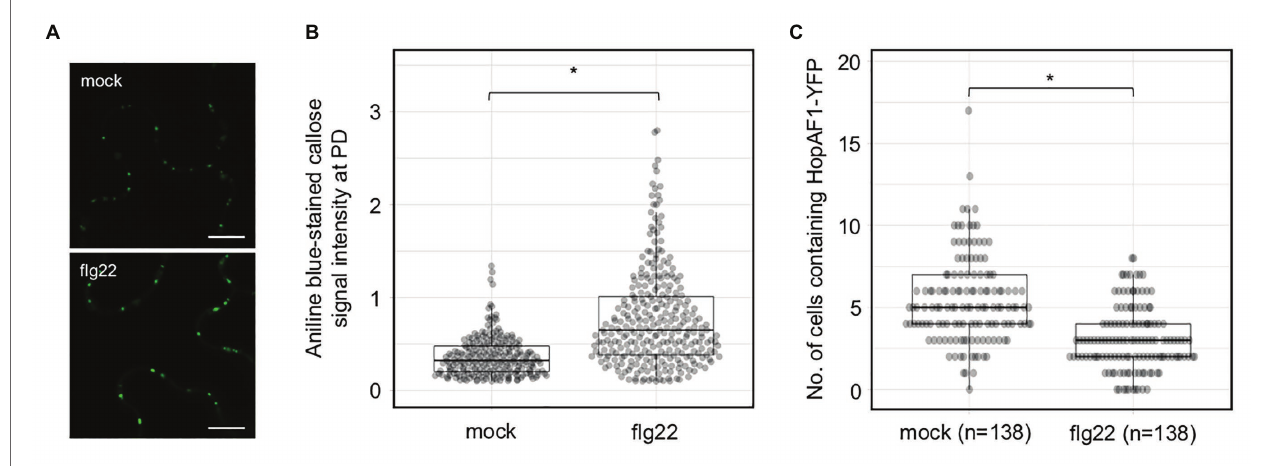
FIGURE 4 | Pattern-triggered immunity (PTI)-induced callose accumulation at PD reduces the movement of effectors. (A) Flagellin (flg22) induces callose accumulation at PD. Nicotiana benthamiana leaves were infiltrated with 0.1 μ M of flg22 or ddH 2 O (mock). Infiltrated leaves were stained with 0.01% aniline blue and imaged with confocal microscopy. Scale bars = 10 μ m. (B) Quantitative data present the accumulation of callose at PD. Mann-Whitney U Test was used to analyze the data. The p -value is <0.00001 (*). (C) flg22 treatment suppresses the PD-dependent movement of HopAF1. Nicotiana benthamiana leaves were pretreated with